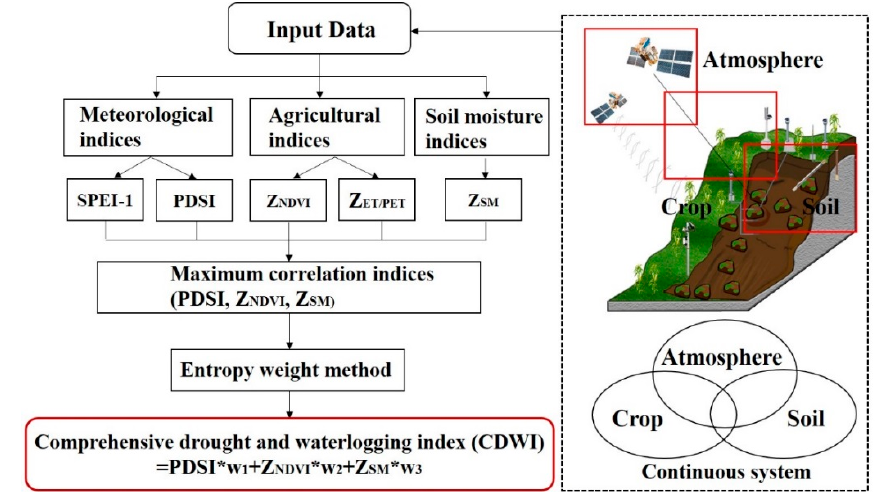
Figure 3. Flowchart of comprehensive drought and waterlogging index (CDWI).